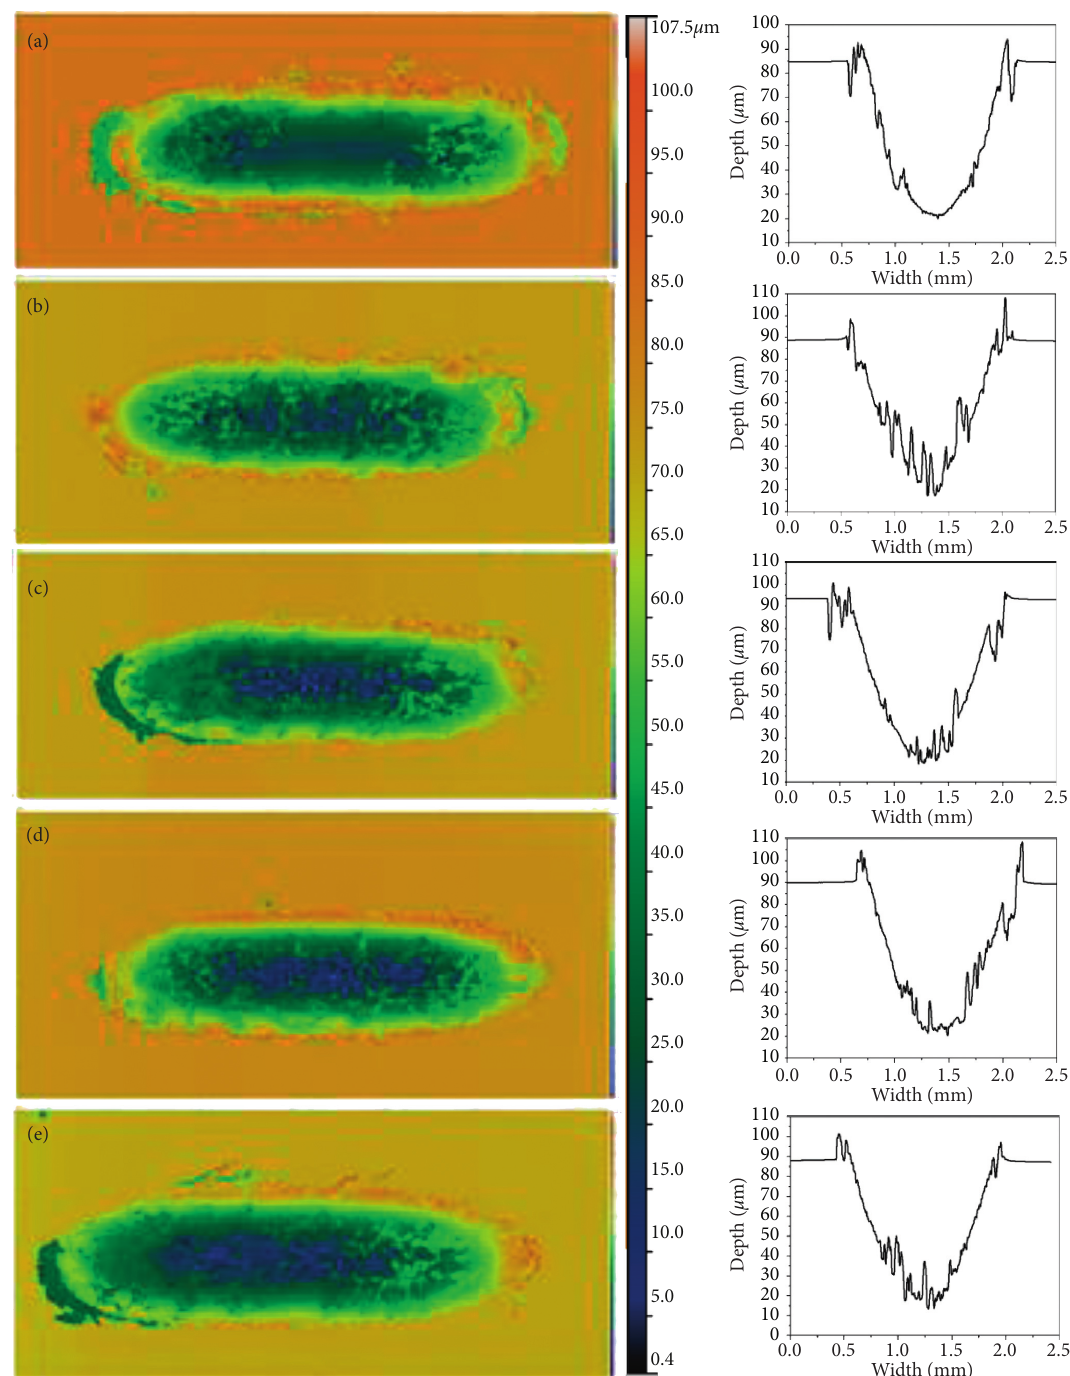
Figure 4: Wear macromorphology and cross-section morphology of samples at different solution temperatures: (a) 1000 ° C, (b) 1040 ° C, (c) 1080 ° C, (d) 1120 ° C, and (e) 1160 °